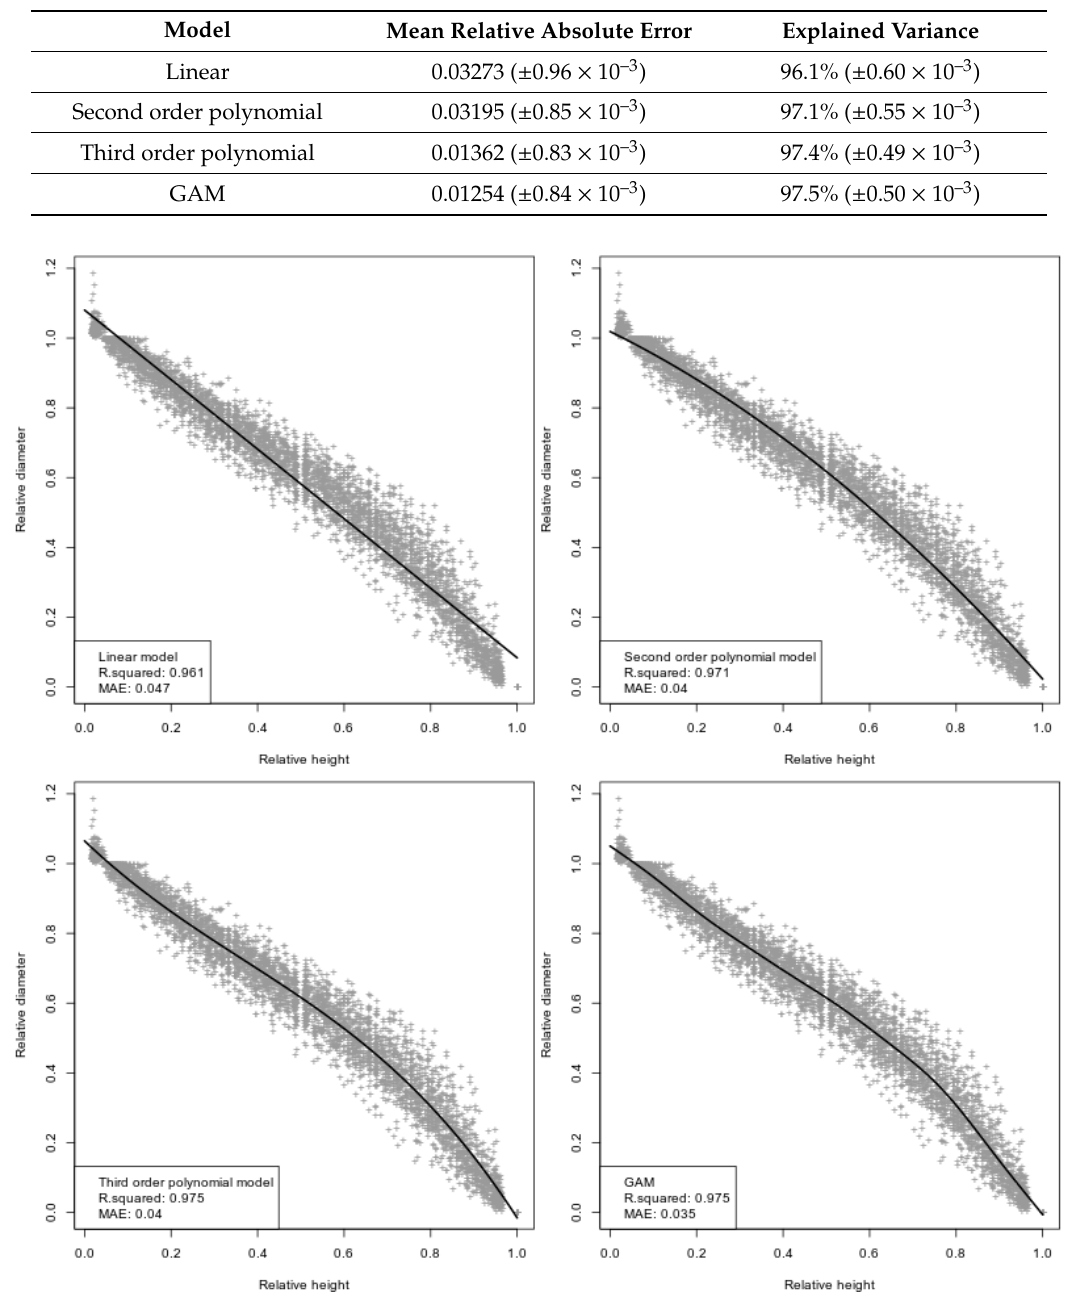
Figure 2. Fitted models on the whole database using the four models. Confidence intervals are not displayed because they were too small and not possible to be observed in a small image.